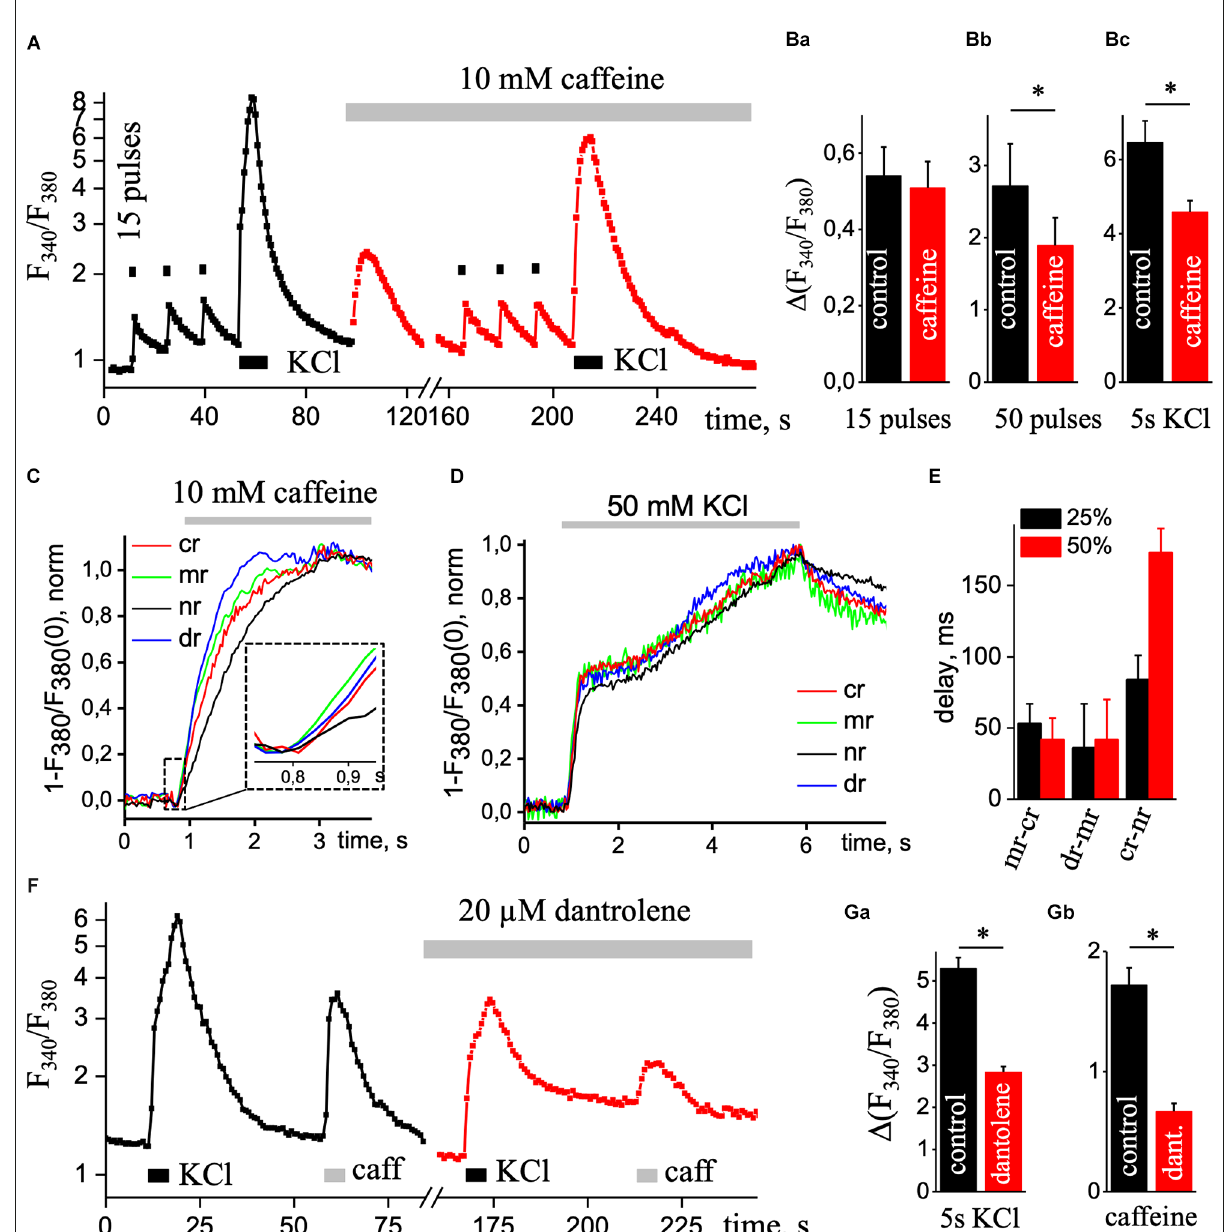
FIGURE4 Ca 2 + transients under the presence of caffeine. (A) Transient increases in [Ca 2 + ] i are triggered by three series of 15 pulses of EFS (black square; 1 s) followed by application of KCl depolarizing solution (KCl, black rectangle, 5 s) in the control condition (black square line) and repeated stimulations with continues presence of 10 mM caffeine (caffeine; red square line) to eliminate calcium release from the ER. Ca 2 + responses were recorded in the soma without the nucleus region. The ratio (F 340 /F 340 ) is presented on a natural logarithmic scale. (B) Mean values of the amplitude of the second Ca 2 + transient caused by 15 (a) or 50 (b) pulses EFS and Ca 2 + transient evoked by KCl solution (c) in control and presence of 10 mM caffeine. Normalized Ca 2 + transients were recorded using one wavelength protocol (33 ms per image and 380 nm excitation wavelength) at different ROIs induced by the application of 10 mM caffeine (C) or application of KCl depolarizing solution (D) . A dashed line in part (C) contains an insert of the initial phase of caffeine-induced Ca 2 + increase. ROIs were selected in central (cr, red line), sub-membrane (mr, green line), nuclear (nr, black line), and dendritic tree (dr, blue line) areas of the cell. (E) Diagram of delays between sub-membrane and central (mr-cr); dendritic tree and sub-membrane (dr-mr); central and nuclear (cr-nr) areas measured at 25% (black bar) and 50% (red bar) of the maximal amplitude in response to KCl depolarizing solution. (F) Transient increases in [Ca 2 + ] i are triggered by the application of KCl depolarizing solution (KCl, black rectangle, 5 s) and caffeine (caffeine, light gray rectangular; 10 mM and 5 s) in the control condition (black square line) and repeated stimulations with continues presence of 20 µ M dantrolene (red square line) to reduce calcium release from the ER. Ca 2 + responses were recorded in the soma without the nucleus region. The ratio (F 340 /F 340 ) is presented on a natural logarithmic scale. Mean value of the amplitude of Ca 2 + transients evoked by depolarizing solution (Ga) and 5 s application of 10 mM caffeine (Gb) . Results are mean ± S.E., ∗ P <